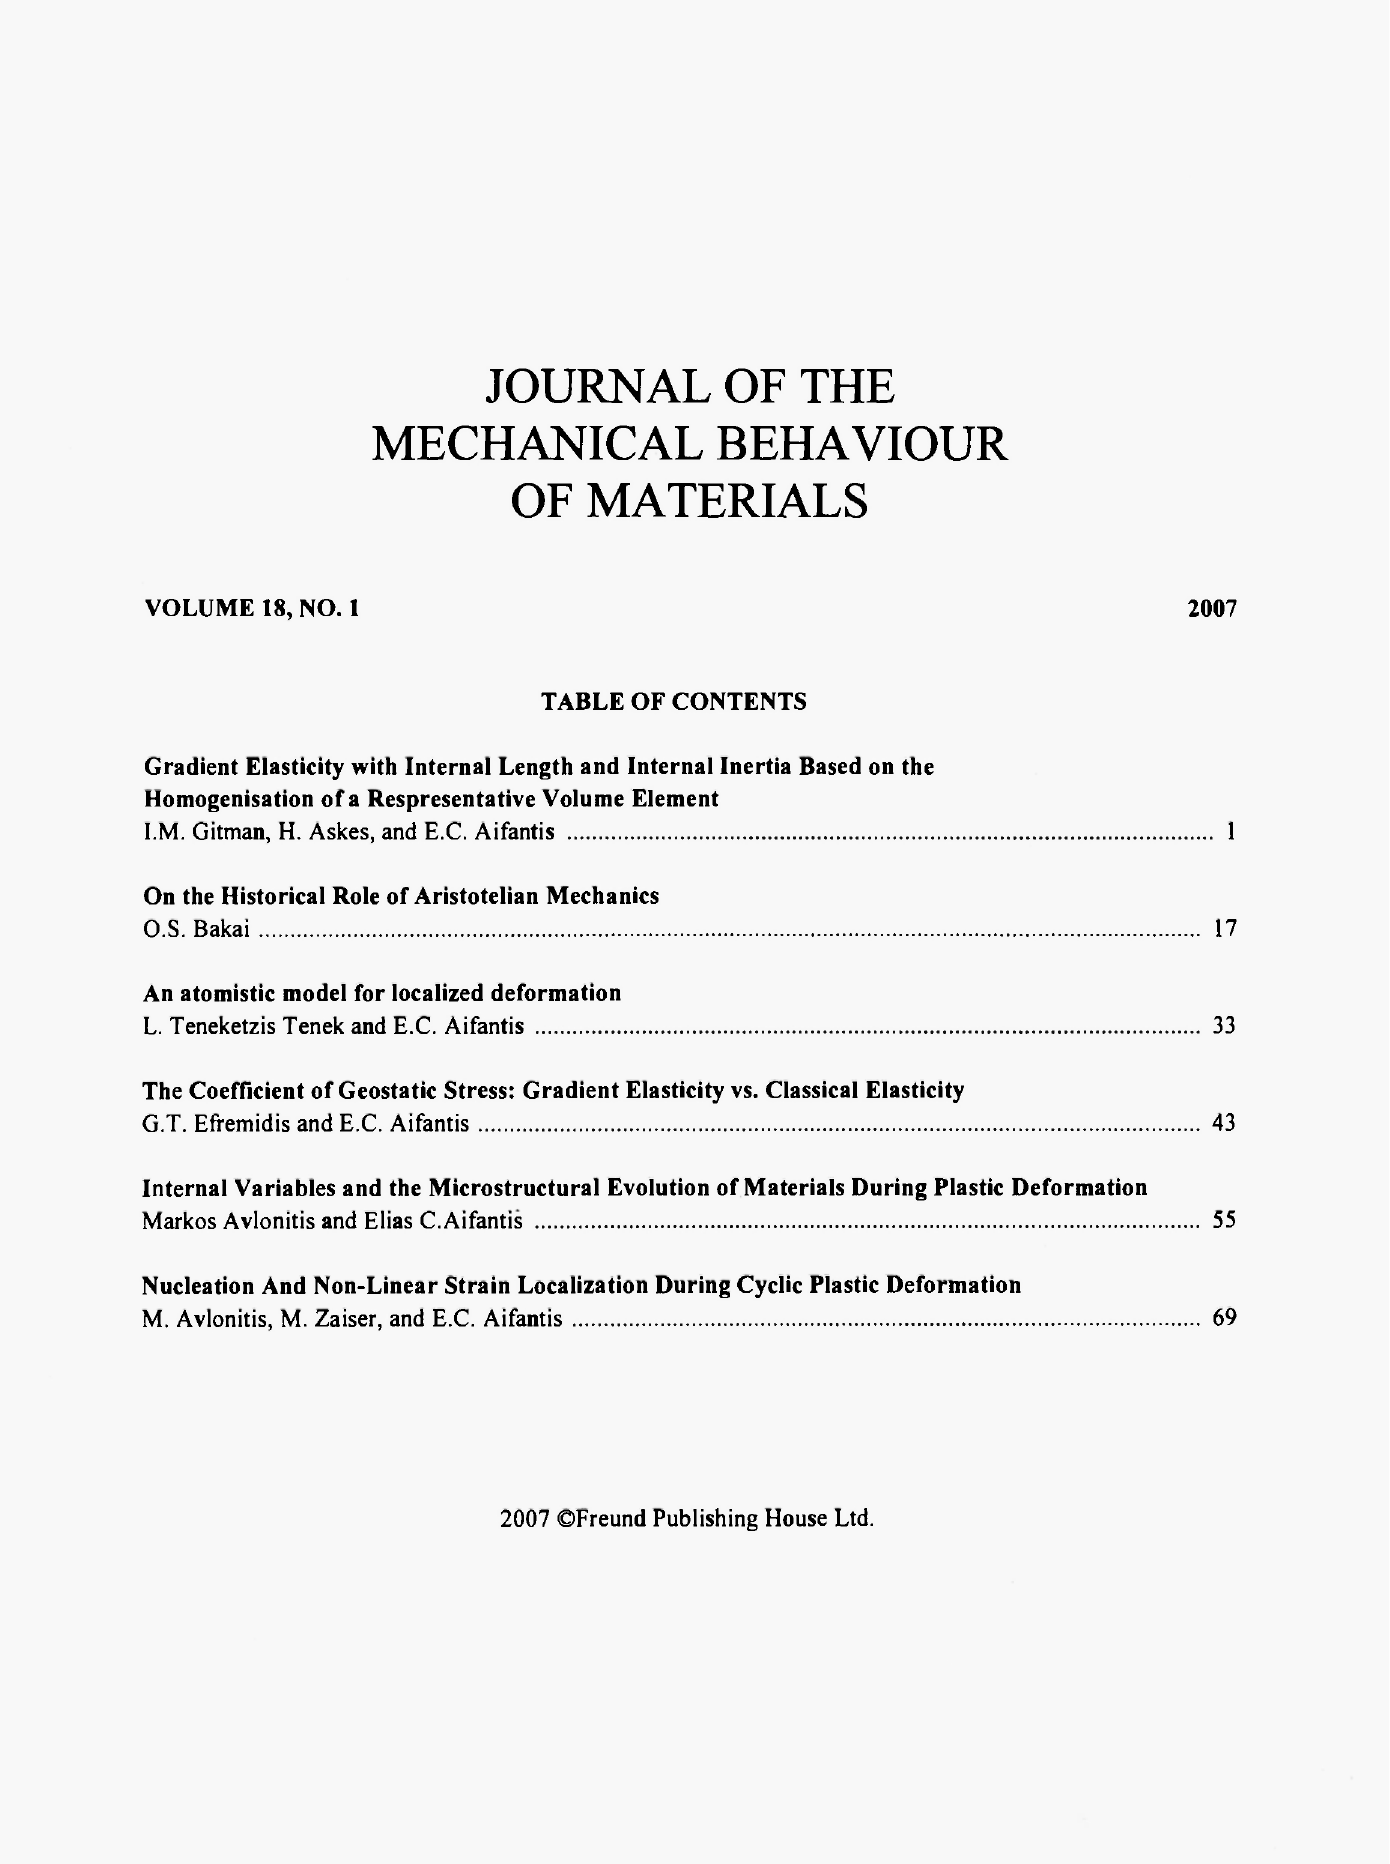
Gradient Elasticity with Internal Length and Internal Inertia Based on the Homogenisation of a Respresentative Volume Element